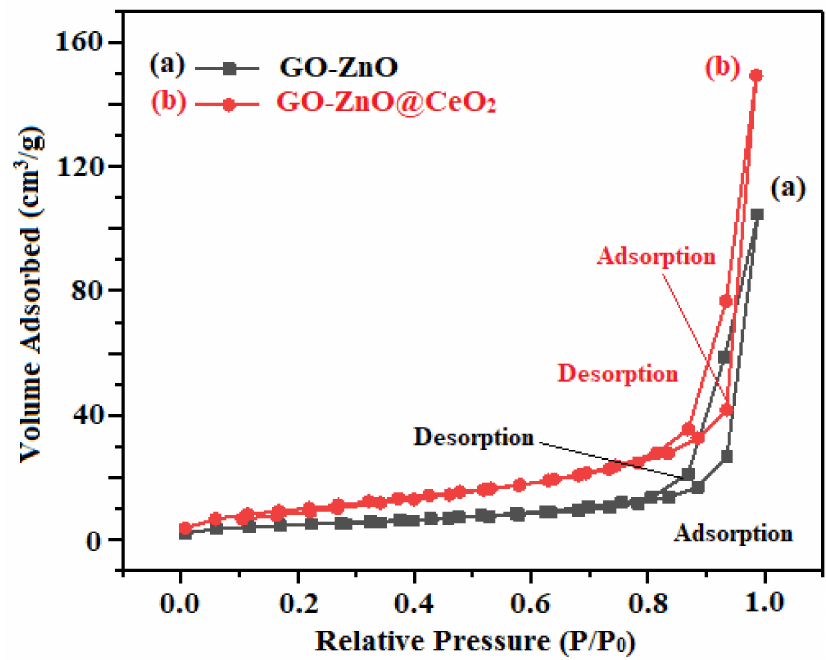
Figure 5. N 2 adsorption/desorption isotherms of ( a ) GO-ZnO and ( b ) GO-ZnO@CeO 2